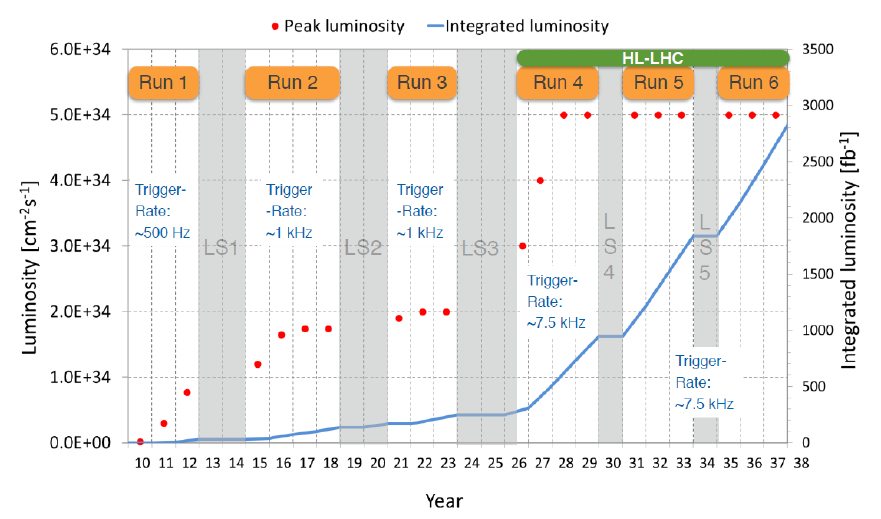
Figure 1. Trigger rates and Luminosity for